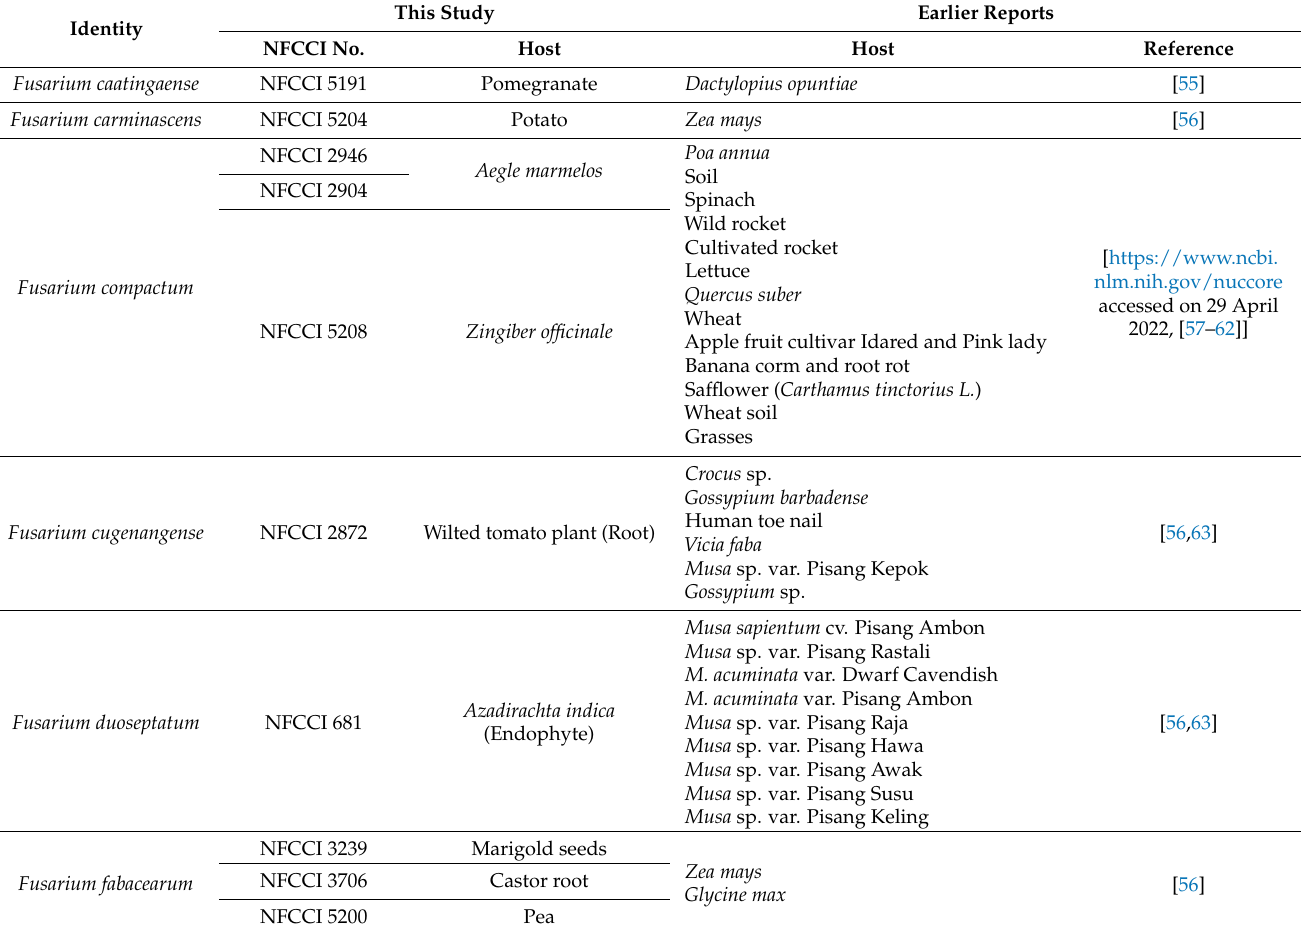
Table 4. New records of Fusarium from India along with their host